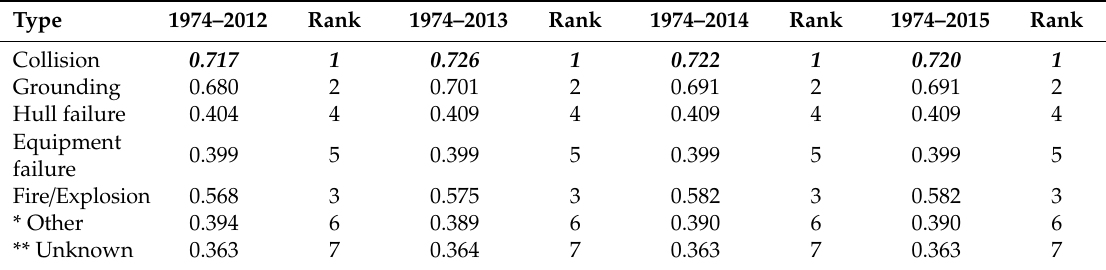
Table 10. Grey relational analysis and ranking of oil spills over 700